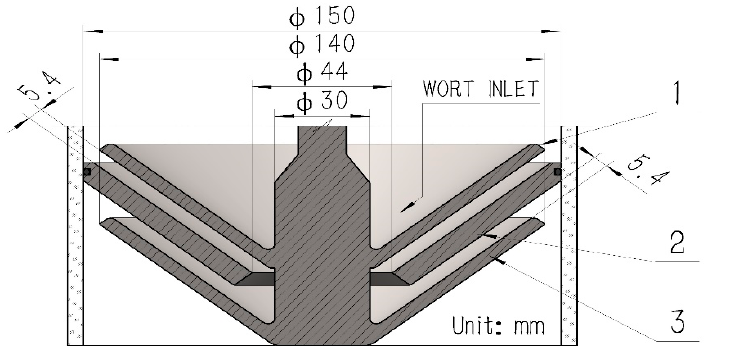
Figure 1. Piping and instrumentation diagram.